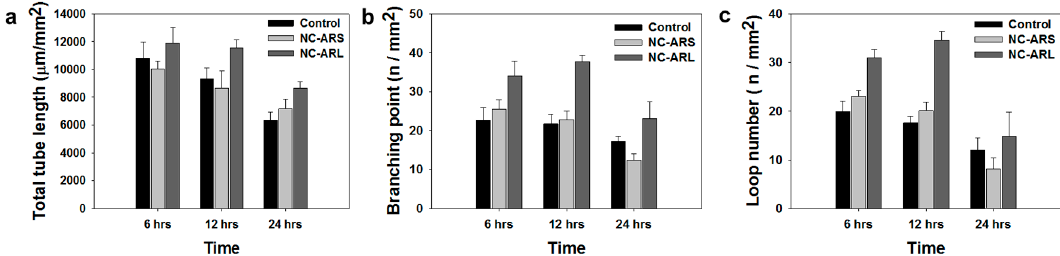
Figure 5. The effect of NCs on capillary-like structure formation: ( a ) total tube length; ( b ) branching points; and ( c ) loop numbers of capillary-like structures of HUVECs on Matrigel without (control) or with NC treatment.